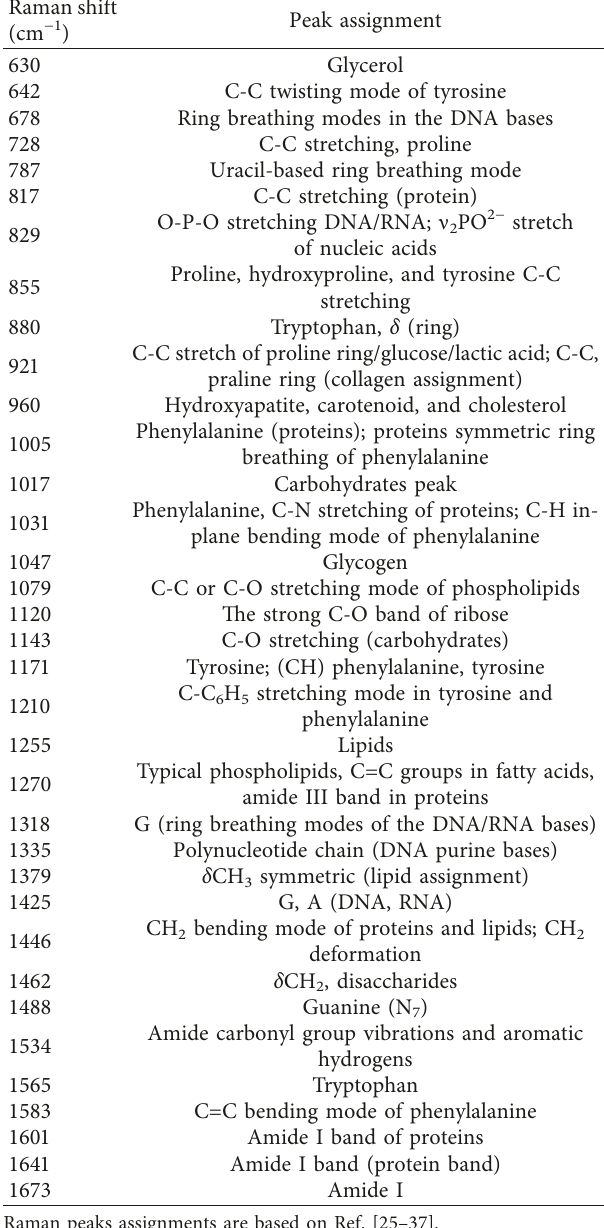
Table 2: Peak assignments for SERS spectra of